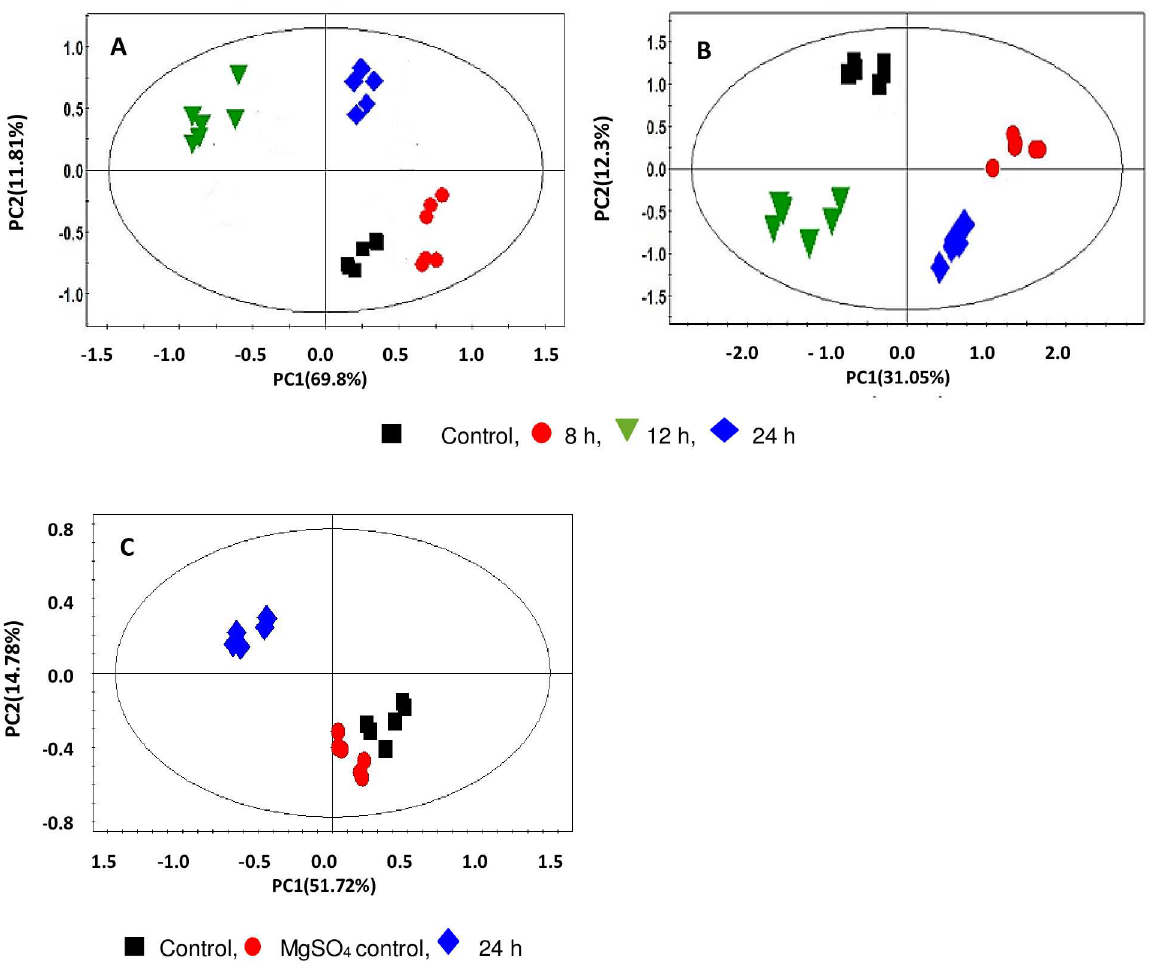
Fig 2. PCA score plots of metabolite content of extracts from (A) cell, (B) medium and (C) leaf tissue. Models are based on the UHPLC-qTOF-MS (positive mode) time study of Arabidopsis cell suspensions comparingcontrol versus 8, 12 and 24 h treatments with LPS. Leaf tissue extracts were prepared24 h post-treatment with LPS and a MgSO 4 treatment control. The plots show intra- and inter group clustering/separationat different time points. Equivalentplots for the data obtained in negative mode are presented in Fig D in S2